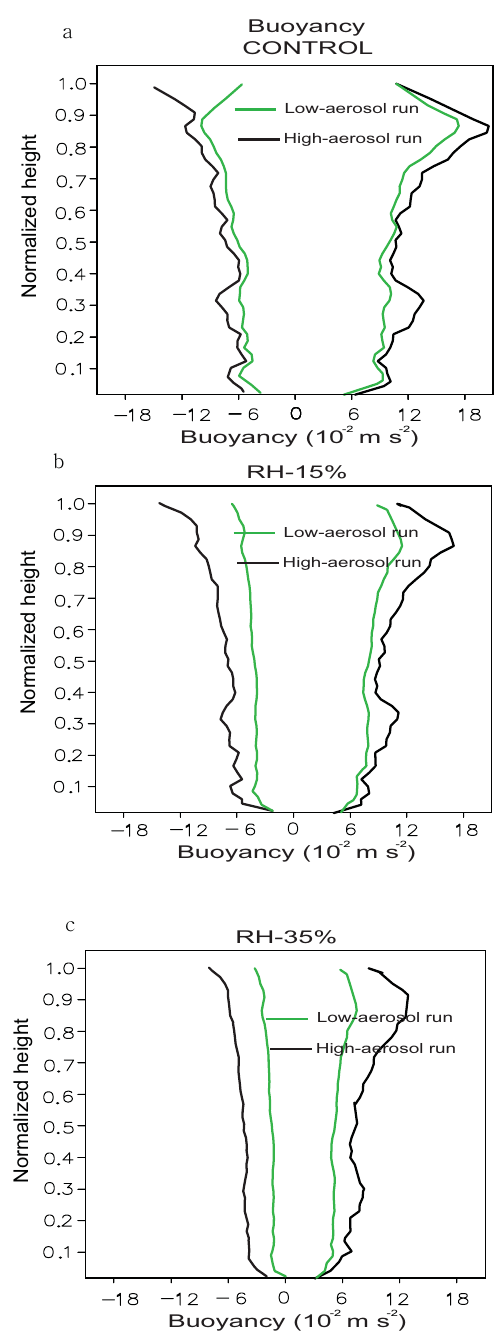
Fig. 8. Normalized profiles of buoyancy (positive and negative) for the high- and low-aerosol runs in (a) CONTROL, (b) RH-15%, and (c)